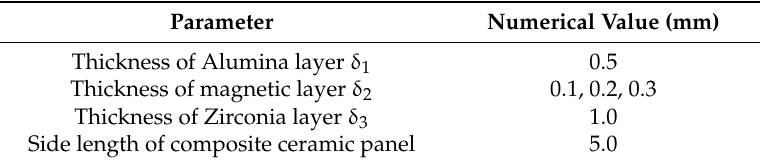
Table 2. Main parameters of the model with a single magnetic interlayer.